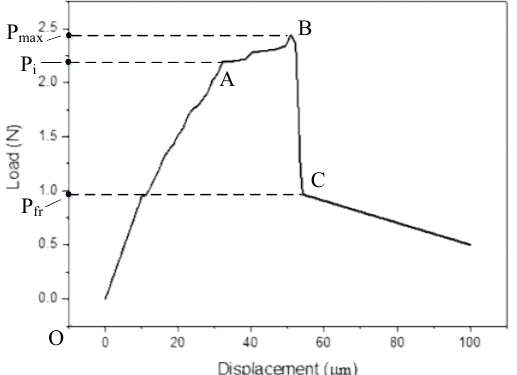
Figure 16. ( a ) The micro morphology before push-out test; ( b ) The micro morphology after push-out test. According to the data collected by the pressure sensor and combining the motion curve of the piezoelectric actuator, the relationship between the force applied on the ejector pin and its motion displacement in the push-out process can be obtained, as shown in Figure 17.